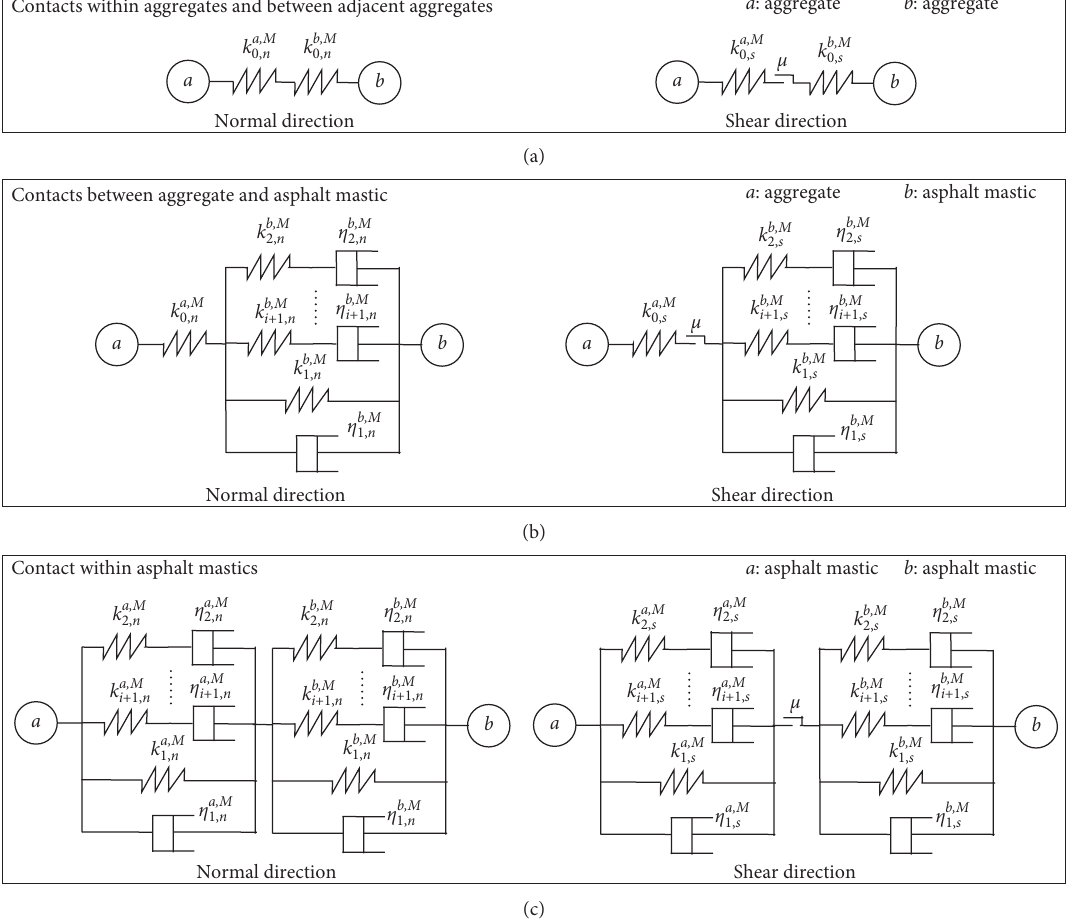
a : aggregate b : aggregateContacts within aggregates and between adjacent aggregates